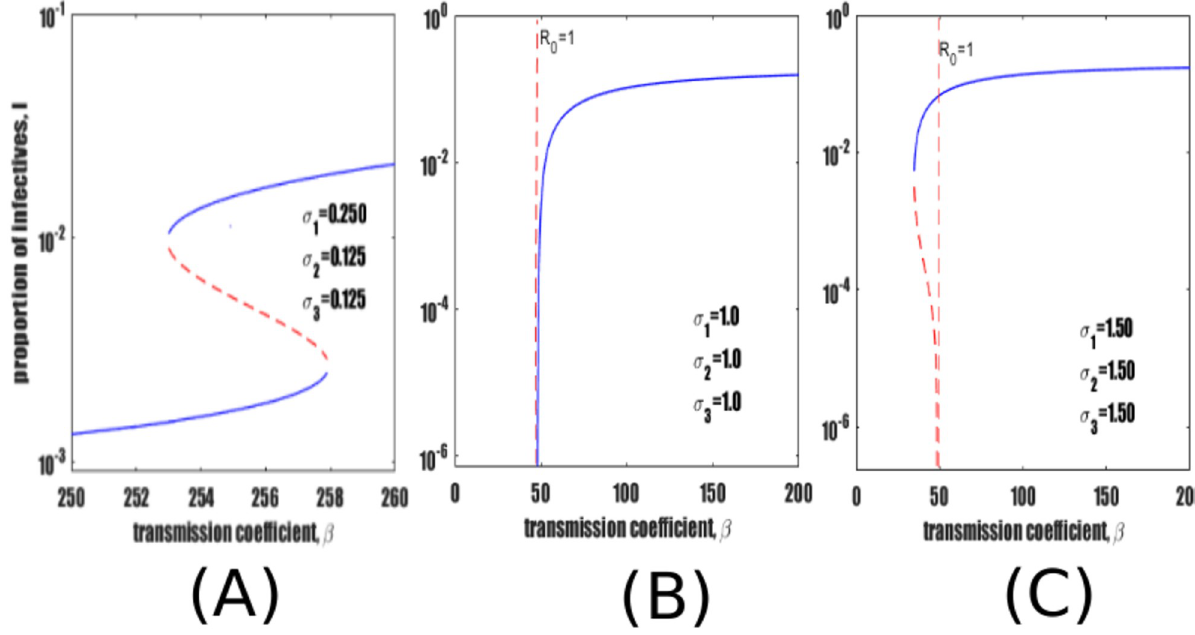
Fig 5. Emergence of hysteresis and backward bifurcation effects with changes to reinfection parameters. Parameters as in Table 1. (A) Occurrence of hysteresis. (B) No reinfection thresholds. All cohorts have immunity equal to susceptible population. (C) Backward bifurcation. All cohorts have no partial immunity and have increased susceptibility to reinfection compared to susceptibles.